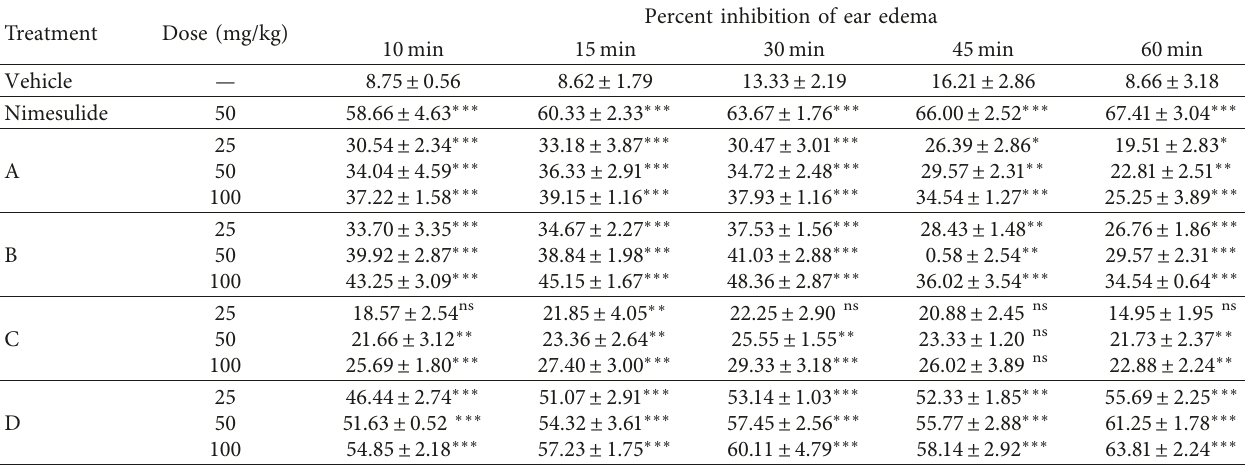
Table 4: Percentage inhibition of compounds in the arachidonic acid-induced ear edema.